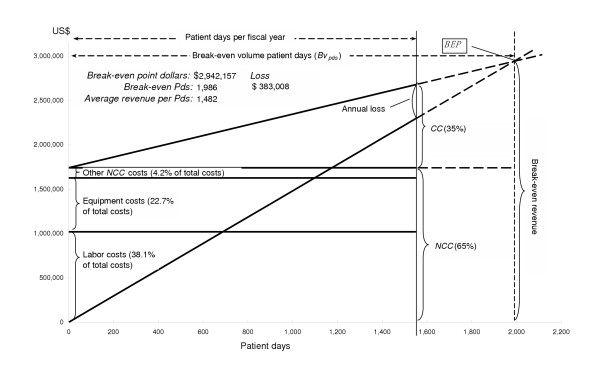
Results of a break-even point analysis for the ICU. BEP: break-even point, pds : patient days, BvPds : break-even volume patient-days, CC: costs that change with the change in the number of patient days, NCC: costs that do not change with the number of patient days